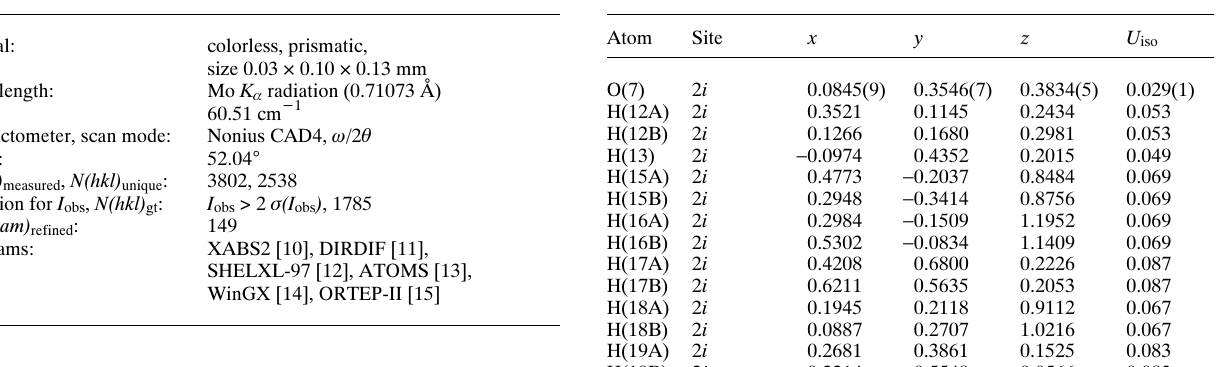
Table 2. Atomic coordinates and displacement parameters (in Å 2 ) . Table 1. Data collection and